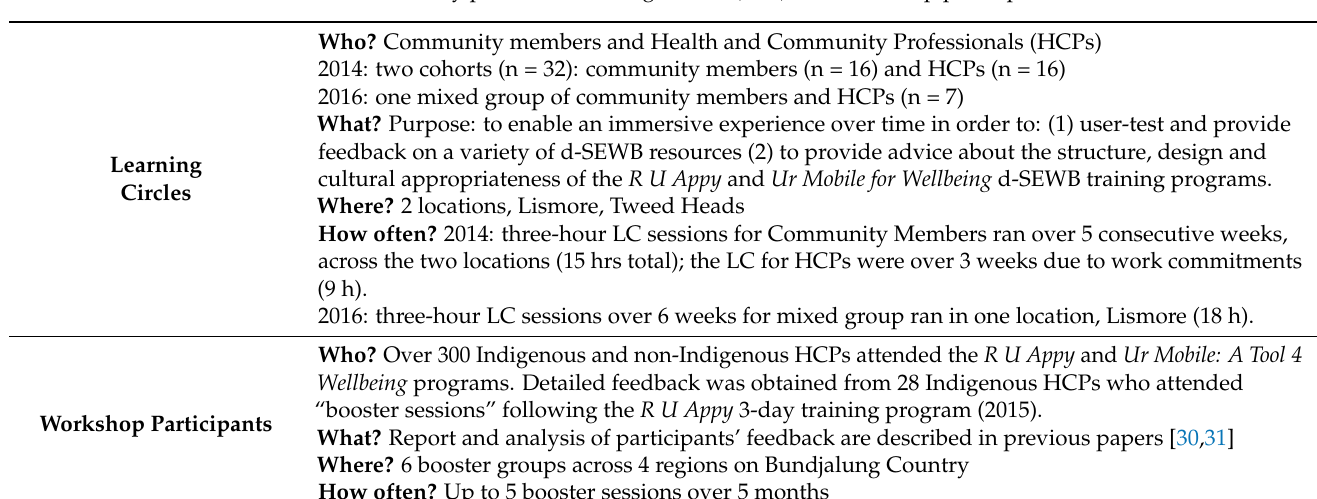
Table 4. Community partners: Learning Circles (LCs) and workshop participants.